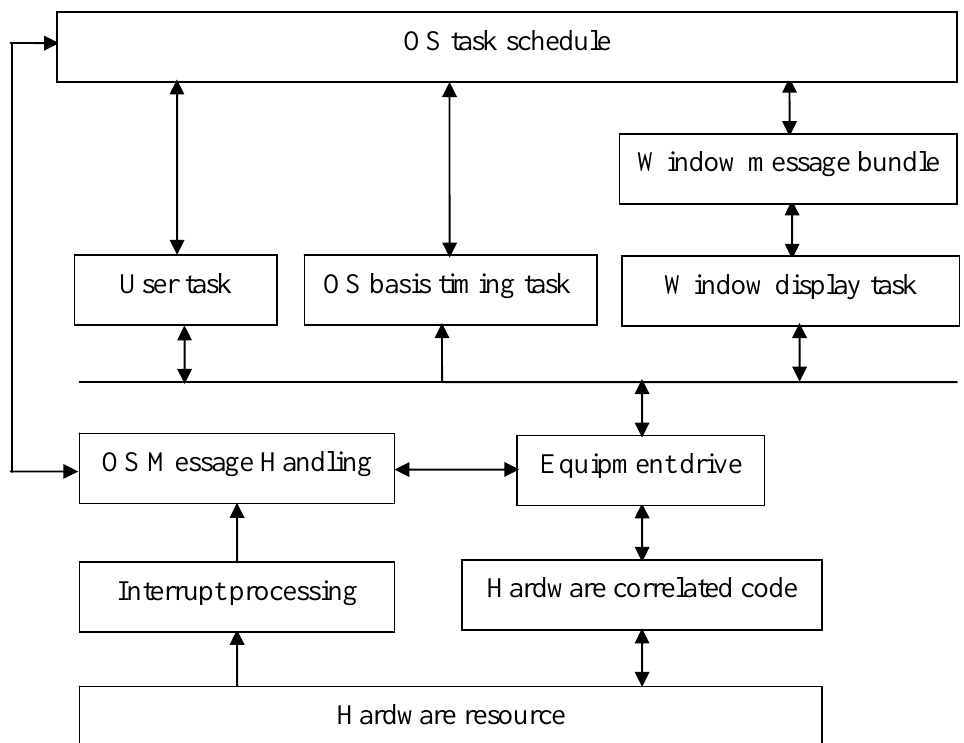
Figure 3. The software structure of